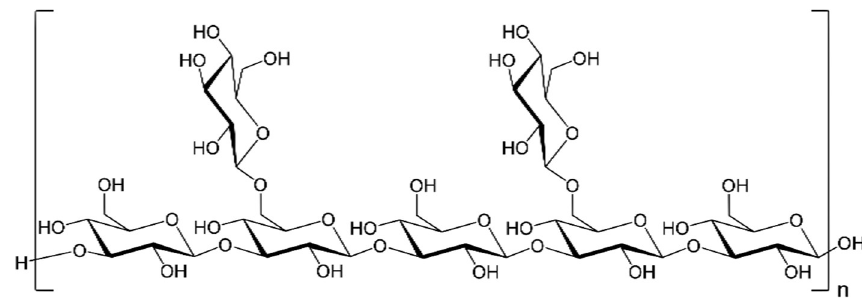
Figure 3. Lentinan structure.